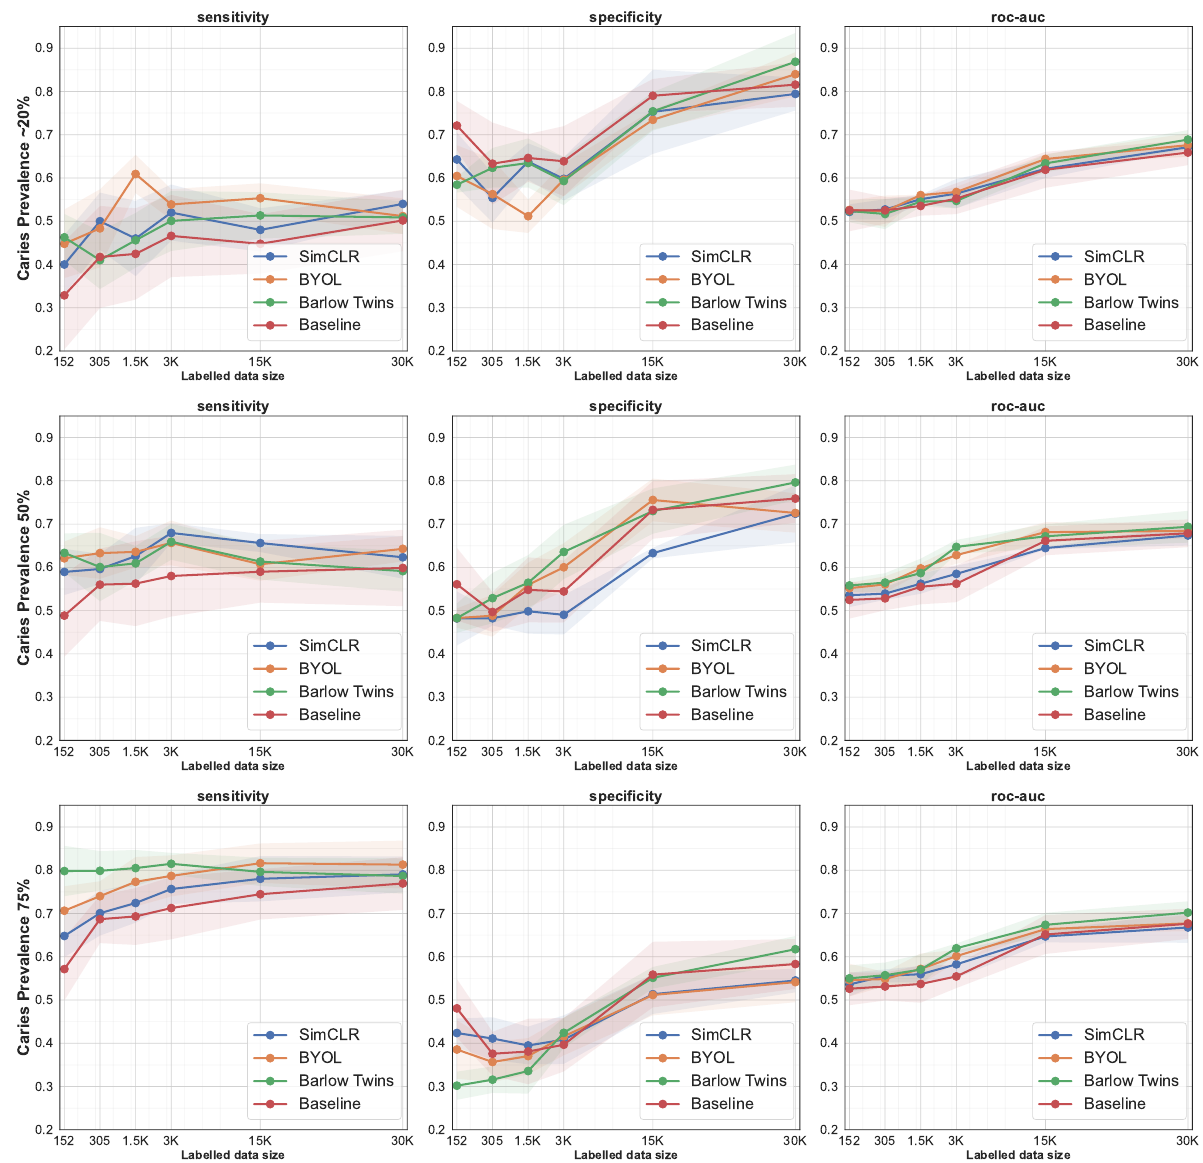
Figure 3. Evaluation results for data-efficiency by successively increasing the size of the training set. Each row represents a different caries prevalence group ( „ 20%, 50%, 75%), and the columns are evaluation metrics (sensitivity, specificity, roc-auc). The plots show the mean for each metric in thick lines and the 95% confidence interval (CI) as